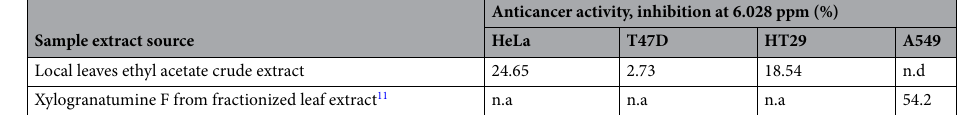
Table 9. Comparison between anticancer inhibition at 6.028 ppm of local X. granatum leaves ethyl acetate extract and Chinese-based fractionized compound Xylogranatumine F against cancer cells 11 . n.a. not available, n.d. not